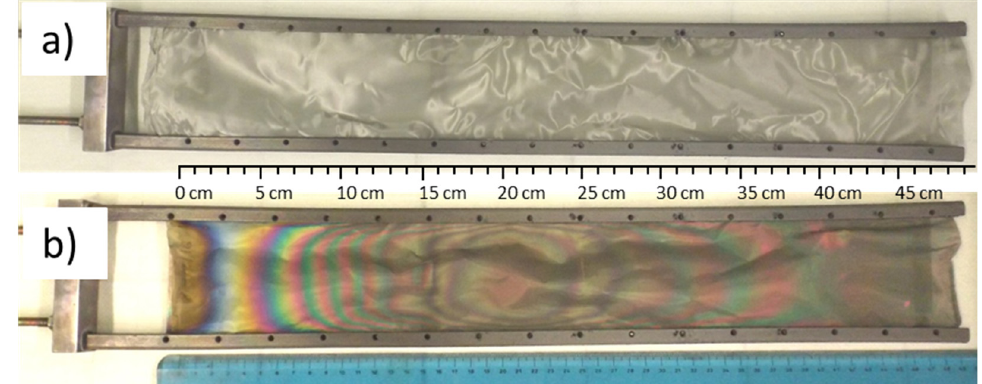
Figure 1. SSM bare substrate ( a ) and TiO 2 -SSM ( b ) fixed to the MOCVD sample holder. Figure 1b helps in analysing the TiO 2 film characteristics. The single-source TTIP/N 2 feed enters into the MOCVD reactor from the right side, then reacts and settles as TiO 2 on